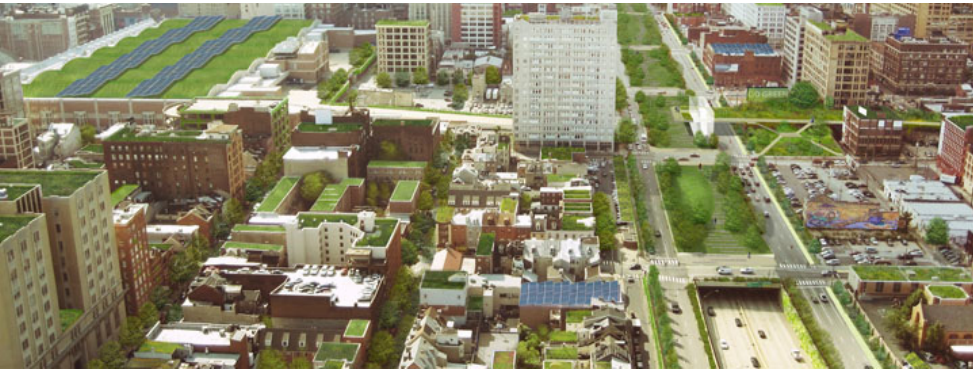
Figure 2. Green waterstorm infrastructure in Philadelphia (USA).